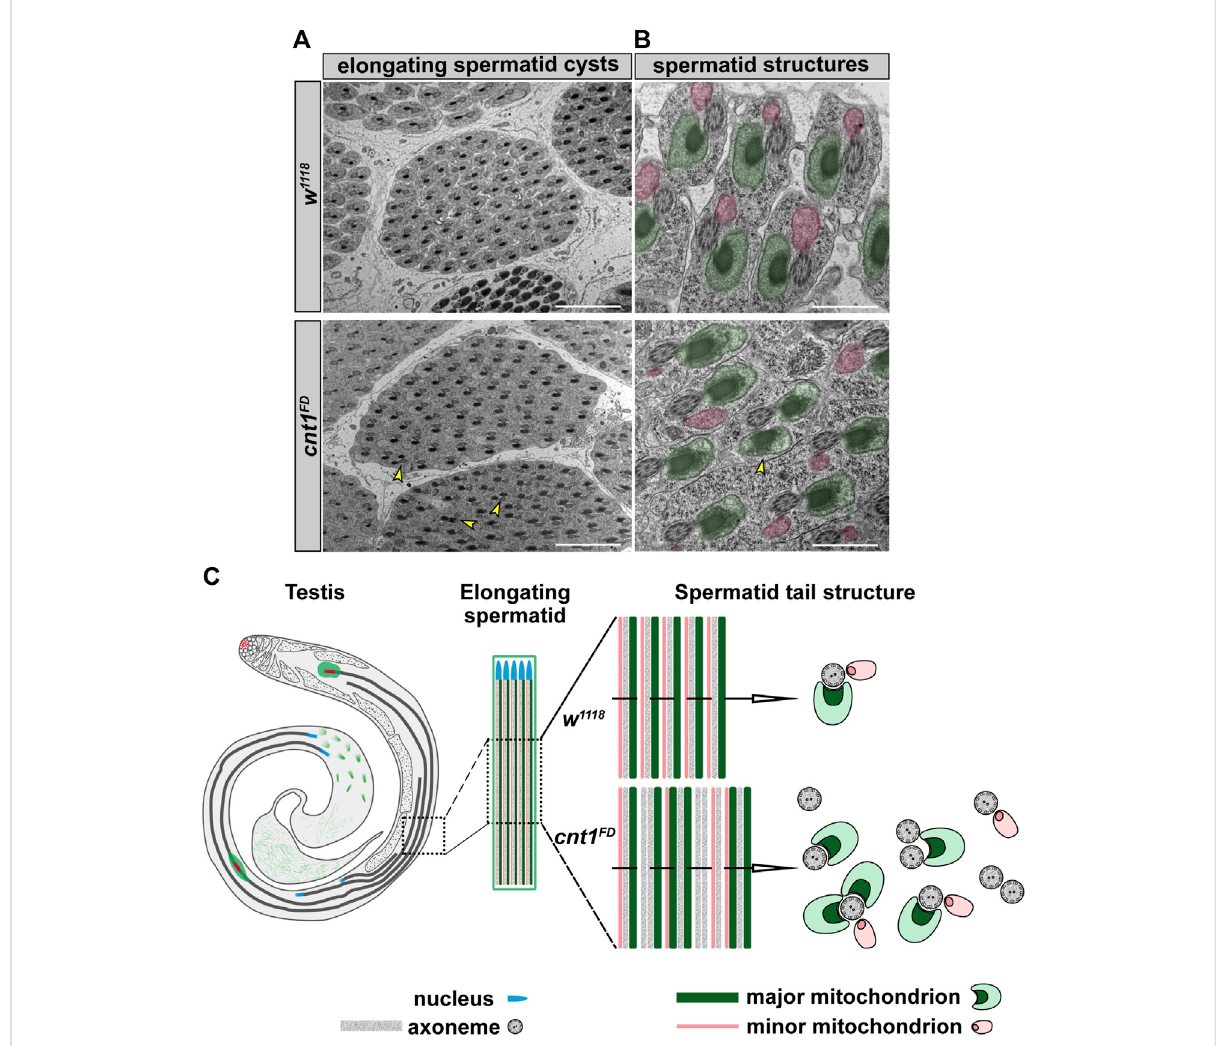
FIGURE 7 The cnt1 mutants exhibit mitochondrial defects. (A) Transversal section of w 1118 and cnt1 FD mutant testes showing a cyst of elongating spermatids. Scale bar: 5 µm. (B) W 1118 shows a normal structure of an elongated spermatid tail with one axoneme, two major mitochondria, and one minor mitochondrion. cnt1 FD shows an abnormal structure of an elongated spermatid tail with one or two axonemes and an abnormal number of mitochondrial subunits. Major mitochondria (highlighted in green), minor mitochondria (highlighted in pink). Scale bar: 1 µm. (C) Summary of observed mitochondrial phenotypes in the cnt1 FD mutant compared with w 1118